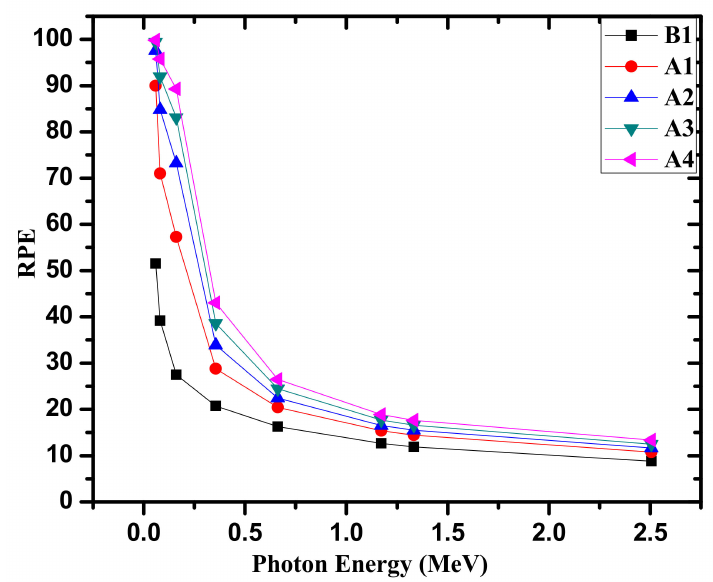
Figure 8. The RPE for the fabricated